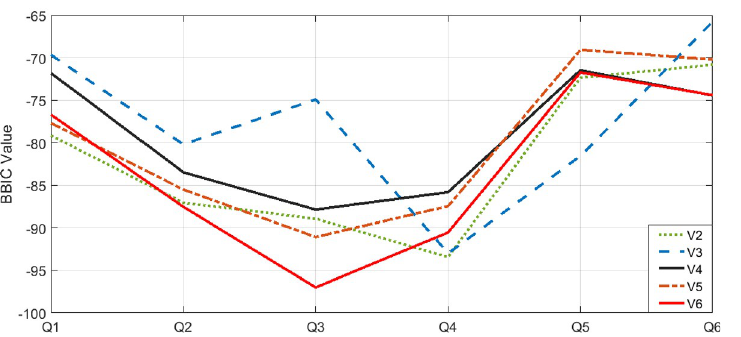
Fig 12. Value of BBIC in each one of the queries for each alphabet in each